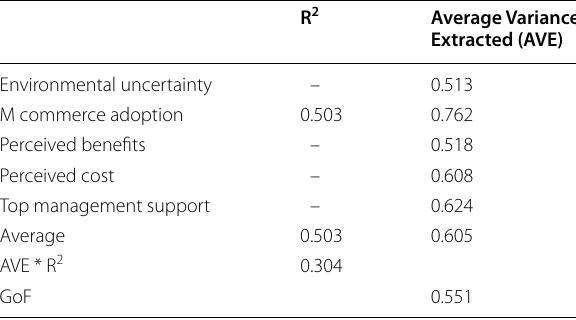
Table 6 R 2 and global fit indices